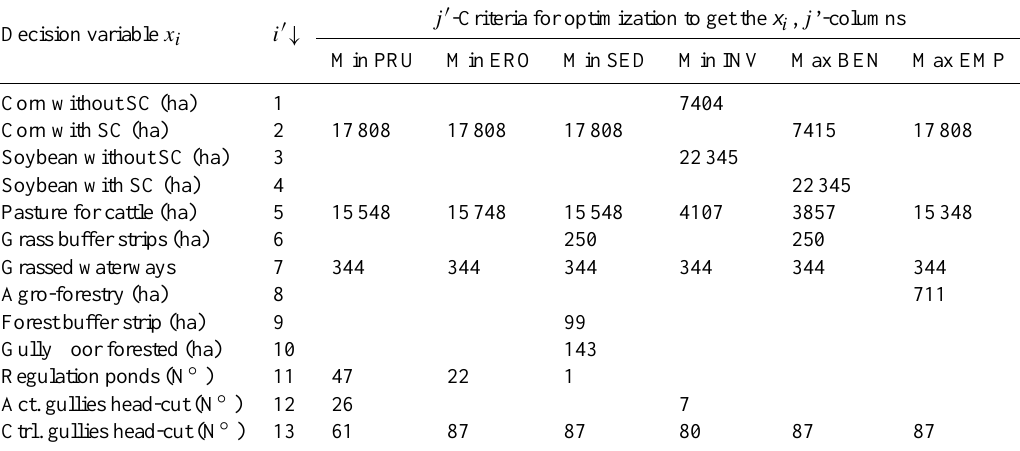
Table 3. Values of the DV by optimising the CV j 0 with GP to get the pay-off matrix PM . Column j 0 contains the DV, and the CV are in the j 0 file of matrix PM in Table 2. Values that are 0 are indicated with a